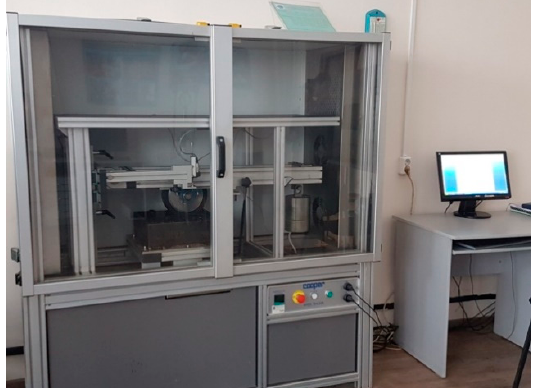
Figure 9. Hamburg wheel tracking machine.